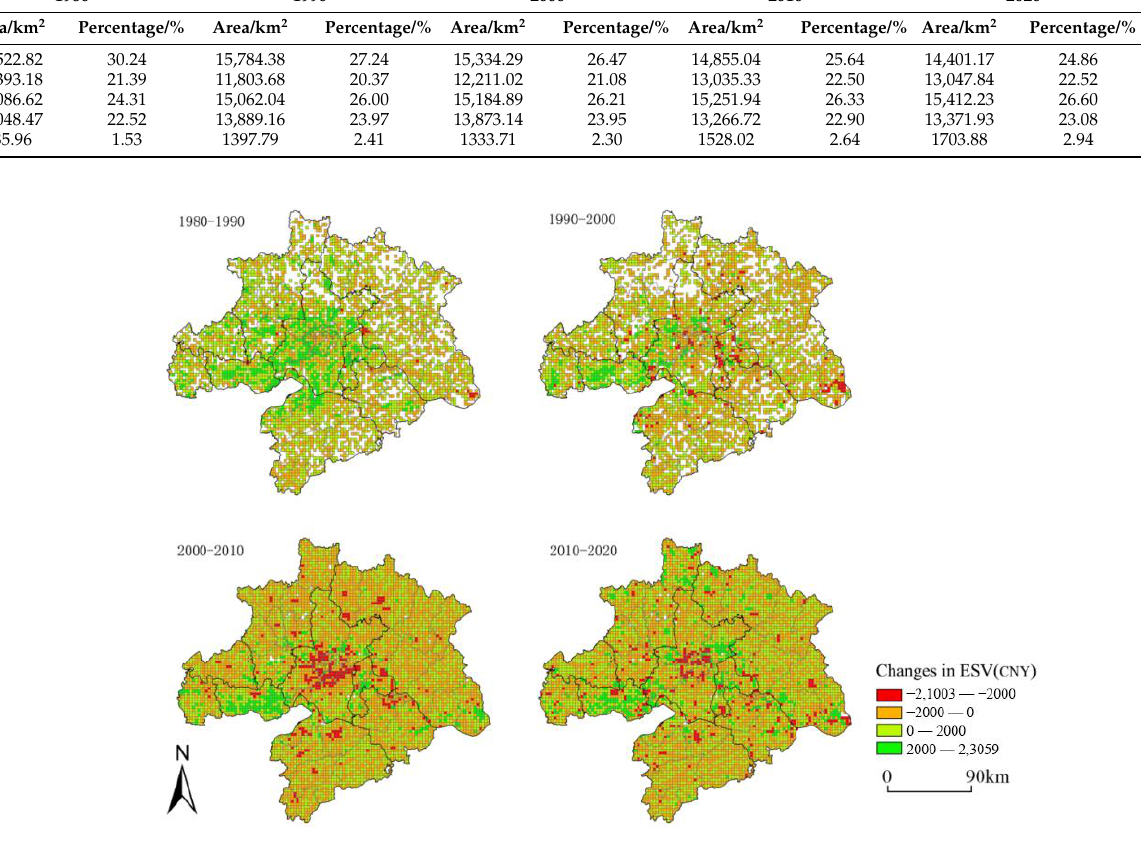
Figure 5. Spatial distribution pattern of ecosystem service value from 1980 to 2020.